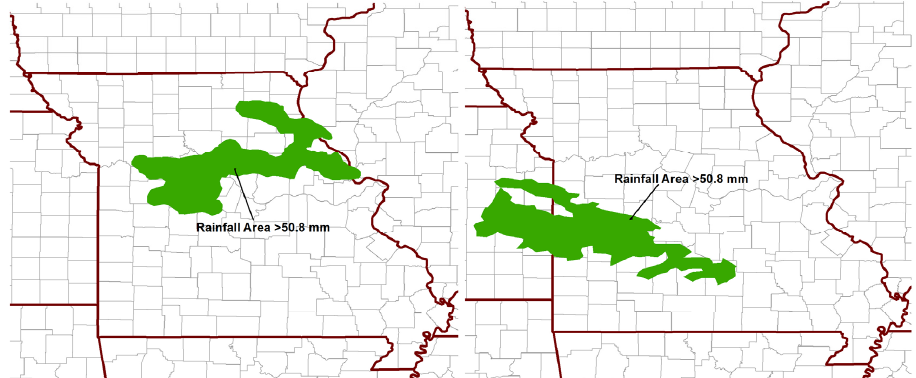
Figure 3. Example of the heavy rainfall area for an elevated thunderstorm case ( left ); and surface based thunderstorm case ( right ). The elevated thunderstorm case occurred 11 September 2010. The surface based thunderstorm case occurred 16 September 2010.